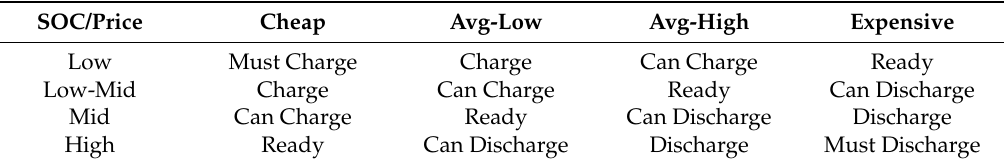
Table 1. Fuzzy rule.